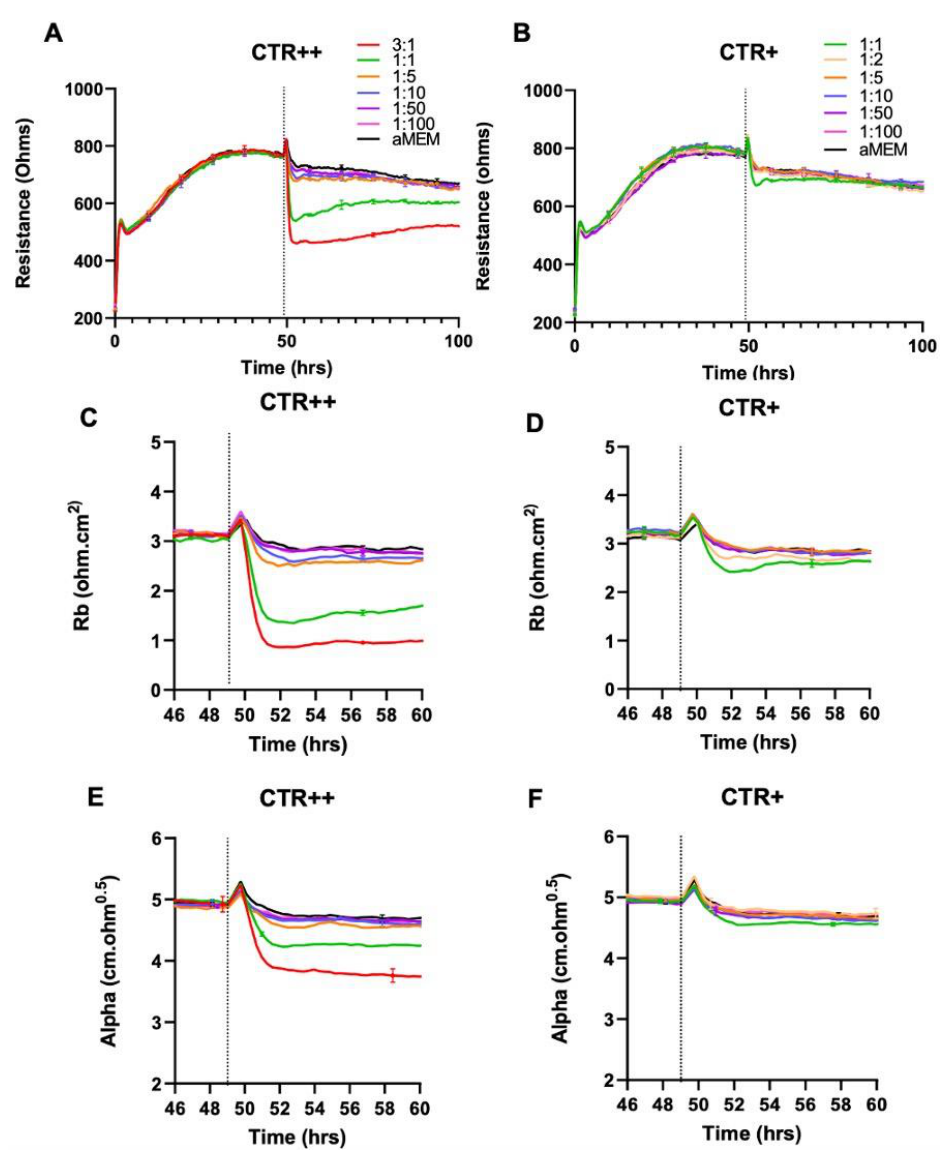
Figure 15. Effect of FACS-isolated CTR++ and CTR+ NZM7-S material on brain endothelial barrier resistance. ( A ) Unmodelled resistance (at 4000 Hz) of isolated CTR++ population of NZM7-S material, ( B ) Unmodelled resistance (at 4000 Hz) of isolated CTR+ population of NZM7-S material. ( C , D ) Changes in the paracellular barrier (Rb) of CTR++ and CTR+, respectively. ( E , F ) Changes in the basolateral barrier (Alpha) of CTR++ and CTR+, respectively. Cells were added at different E:T ratios, where 1:1 shows 1 NZM7-S event as counted with the Accuri C6 flow cytometer to 1 endothelial cell. NZM7-S material was added at 49 h. Data shown as mean ± SD ( n = 3 wells) from 1 experiment, which is representative of 2 independent experiments.